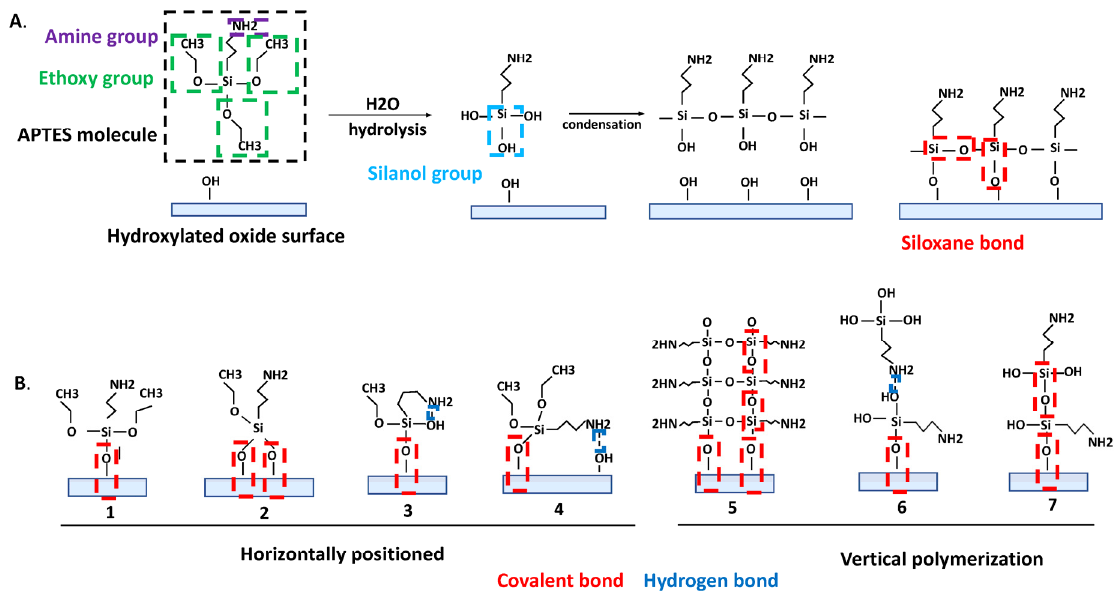
Figure 1. ( A ) Schematic representation of an APTES molecule, activation, and reaction with the hydroxylated oxide surface in an ideal situation. ( B ) Chemical interactions involved in APTES grafting on the hydroxylated oxide surface.